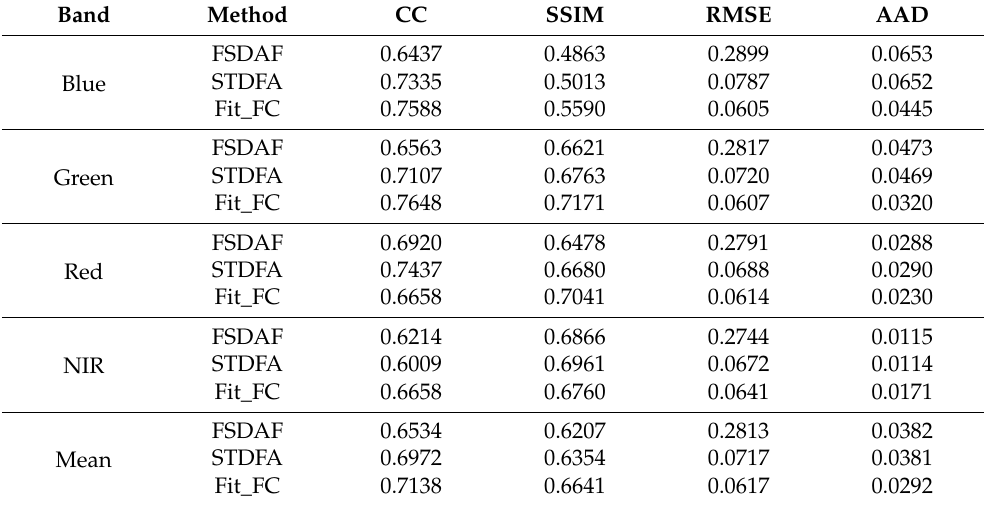
Table 3. The fusion accuracy evaluation of different bands for different models.